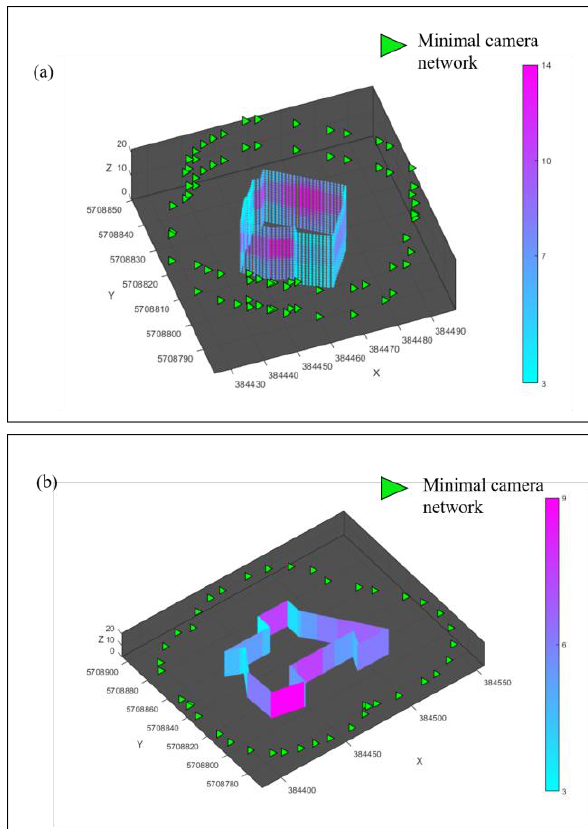
Figure 8 Minimal camera network (a) real (b) synthetic building